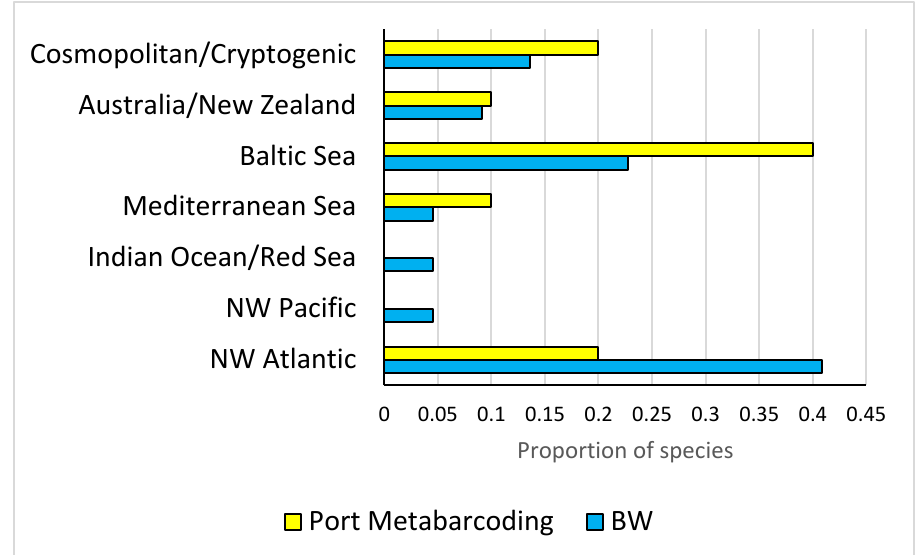
Figure 5. Proportion of non-native algae species from different regions found in BW released in Gijon port, compared with non-native algae detected in port waters from eDNA metabarcoding (Borrell et al. 2017).